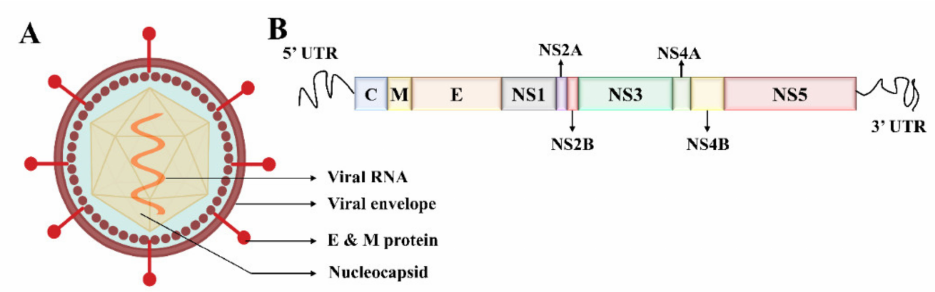
Figure 2. Structure of the dengue virus and evolution. ( A ) Dengue virus is spherical and about 40–60 nm in size. Genomic RNA and nucleocapsid proteins are covered by a membrane called Envelope. ( B ) The complete dengue virus genome is ~11 kb long, consisting of three structured and seven non-structured proteins and two untranslated regions (not drawn to the